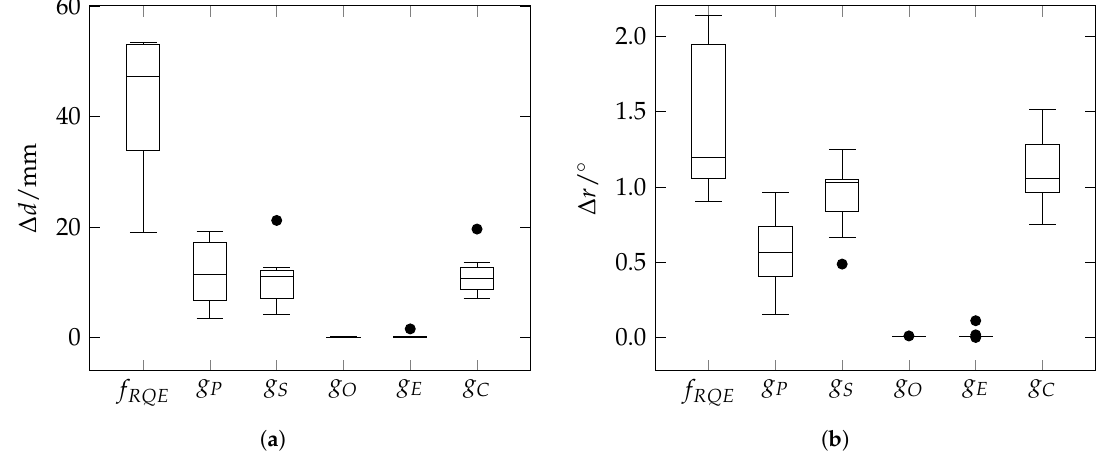
Figure 3. Calibration results depending on the f RQE and the features of planarity ( g P ), sphericity ( g S ), omnivariance ( g O ), eigenentropy ( g E ) and change of curvature ( g C ). ( a ) shows the translation error, ( b ) the rotation error. The feature of linearity has turned out to be unsuitable for the calibration approach and is not shown for display reasons. The features of omnivariance and eigenentropy clearly outperform f RQE and all other